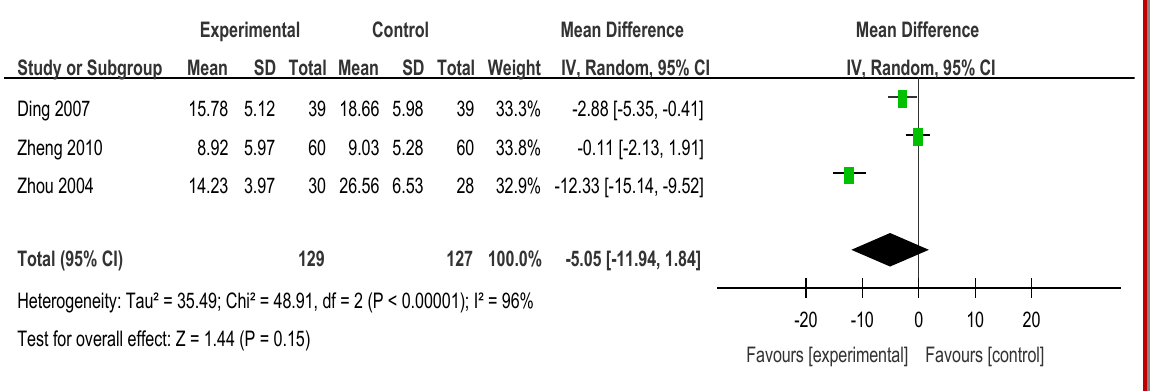
Study or Subgroup